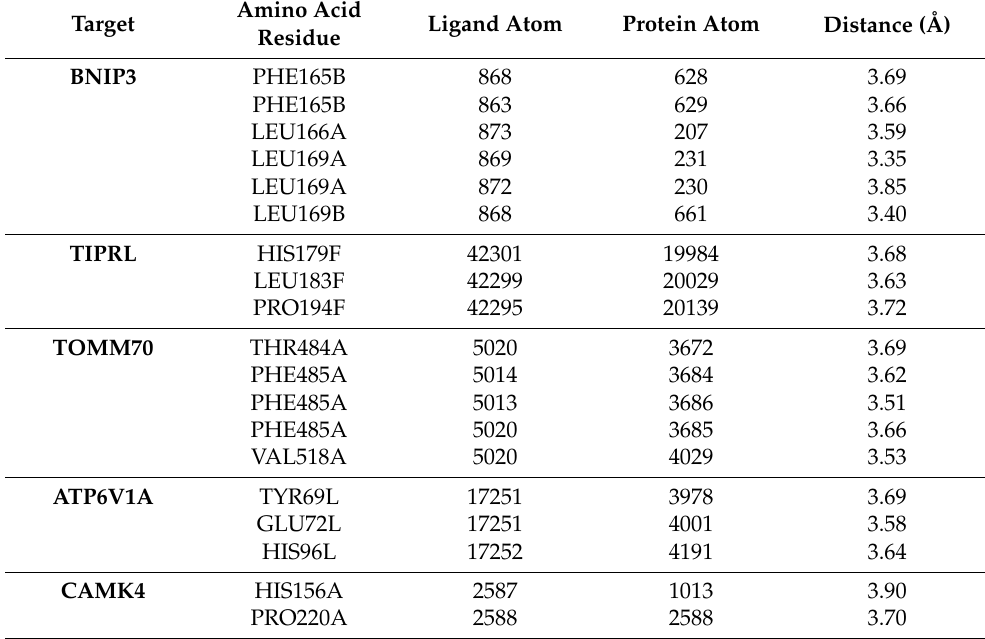
Table 7. Hydrophobic contact between antrocin and various